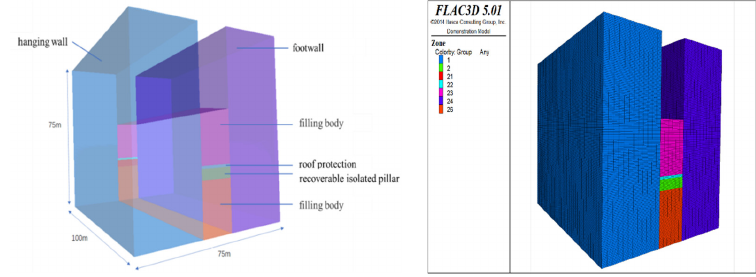
Figure 3. 3D numerical model of mine based on FLAC 3D .